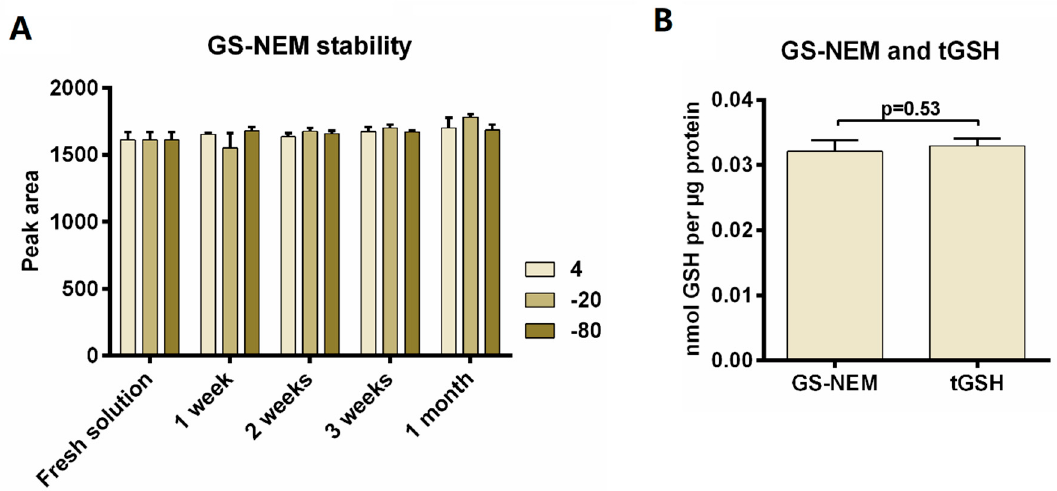
Figure 4. GS-NEM standard solution stability test and comparison of GS-NEM determination with total glutathione (tGSH) quantification in LS174T wild type cells. ( A ) GS-NEM stability was